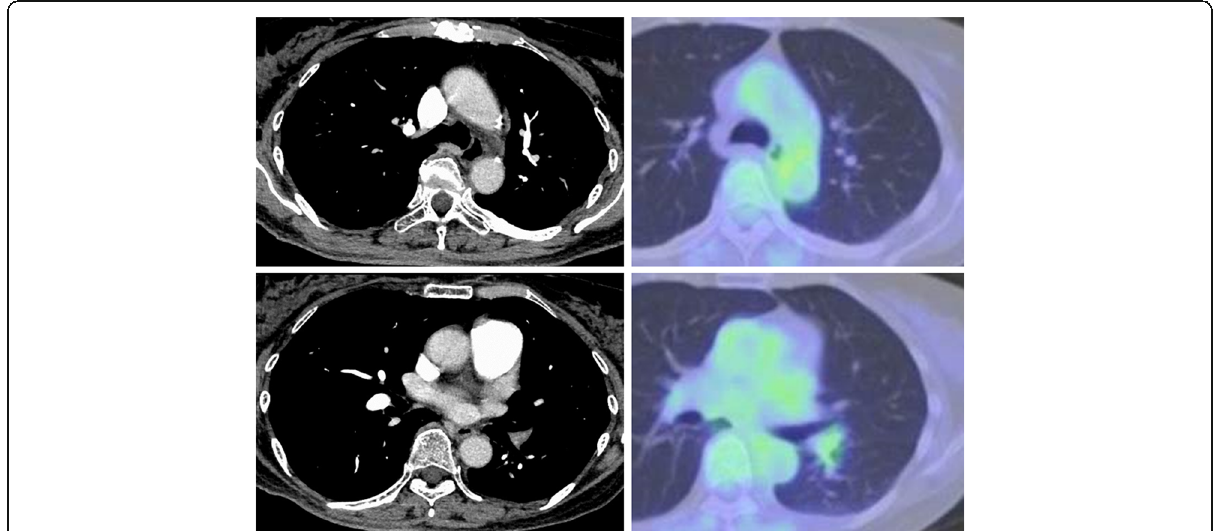
Fig. 2 Computed tomography and positron emission tomography after the treatment with